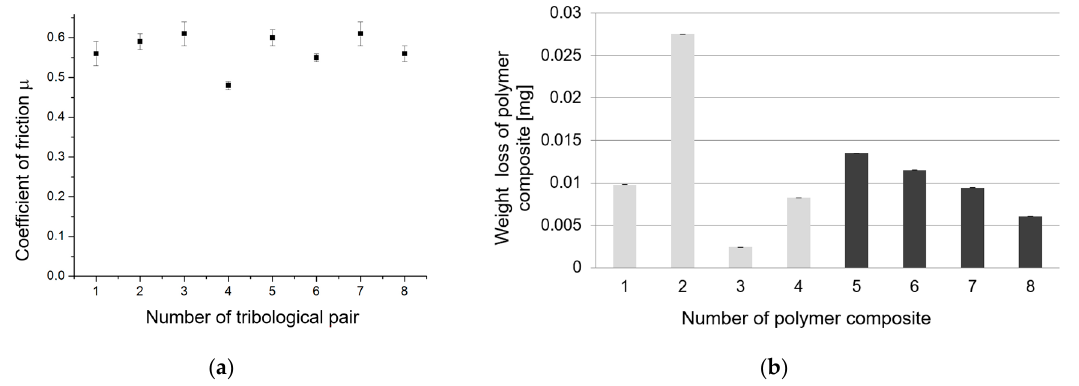
Figure 18. ( a ) Average values of coefficient of friction for tested tribological pairs and ( b ) weight loss of polymer composites.